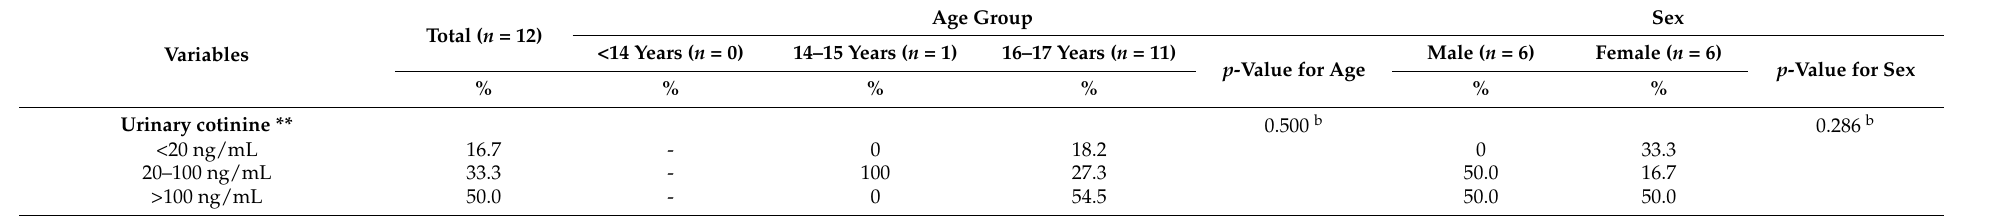
Table 5. Health outcomes among tobacco farmers stratified by age group and sex. S ã o Lourenço do Sul, Rio Grande do Sul, Brazil,